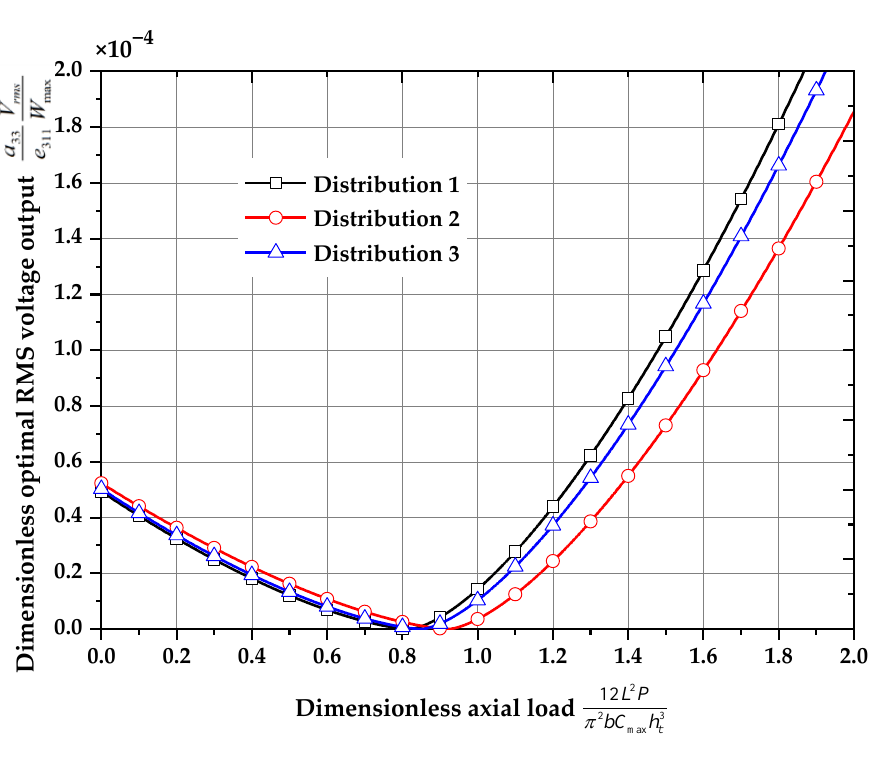
V rms )-axial load ( 12 L 2 P ) e 311 W max π 2 bC max h 3 t